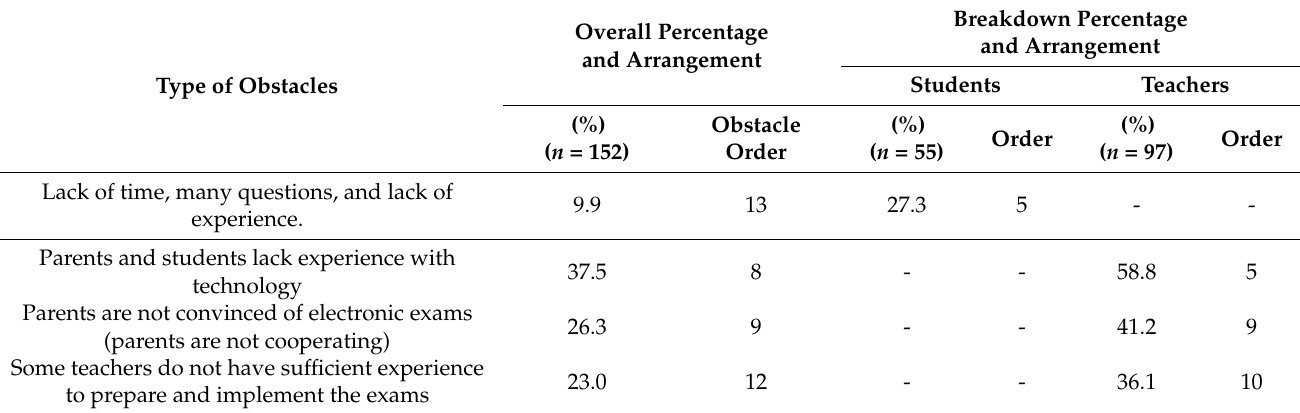
Table 6. The significant obstacles not shared between university teachers and students. Type of Obstacles